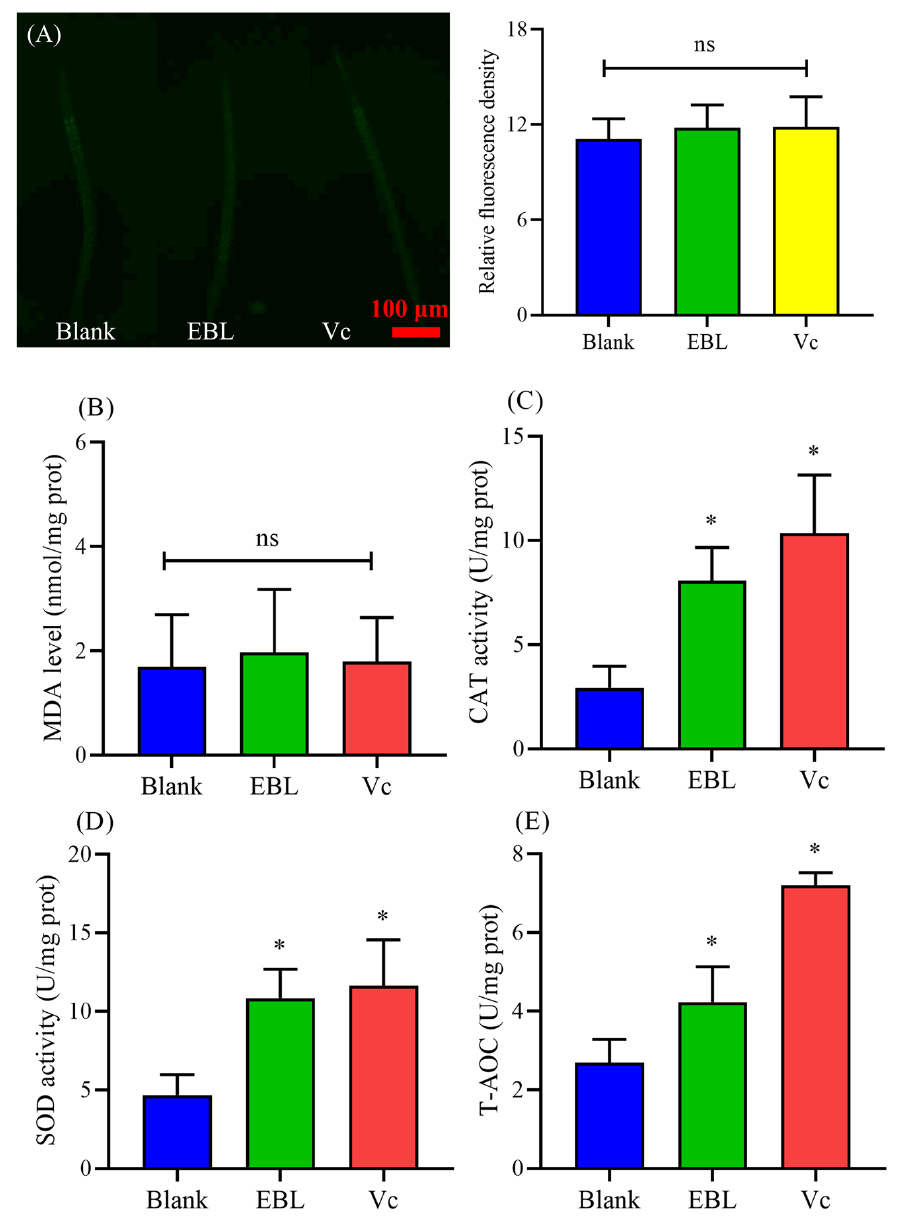
Figure 6. The effect of EBL on the antioxidant defense system of C. elegans under normal stress. ( A ) The level of ROS and ( B ) the content of MDA. The activities of ( C ) CAT and ( D ) SOD enzymes. ( E ) The total antioxidant capacity (T-AOC). The concentration of EBL was 0.1 mg/mL. Vc meant ascorbic acid (10 µ g/mL). Note: * meant p < 0.05 and ns meant not significant.